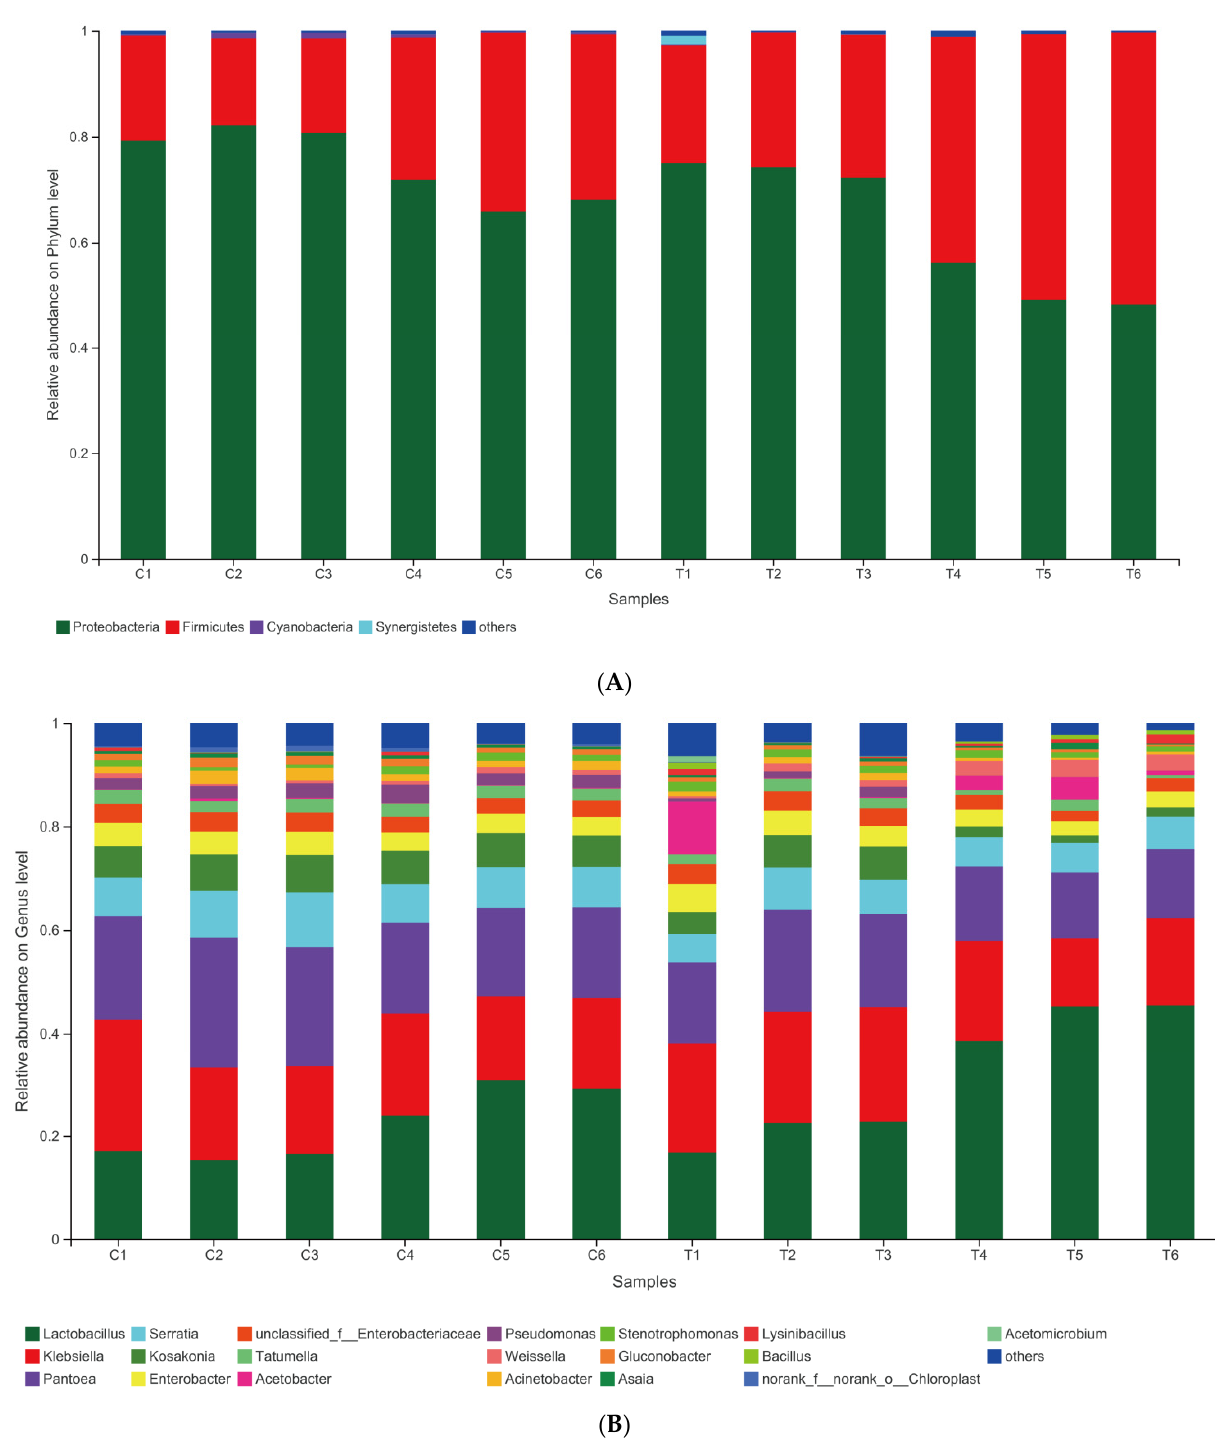
Figure 1. Relative bacteria abundance in two groups at phylum ( A ) and genus ( B ) levels: C, control group, WPCS without inoculant; T, treatment group, WPCS treated with B. subtilis inoculant. The numbers 1, 2, 3, 4, 5, and 6 represent days 1, 3, 5, 10, 30, and 45 of the ensiling process.